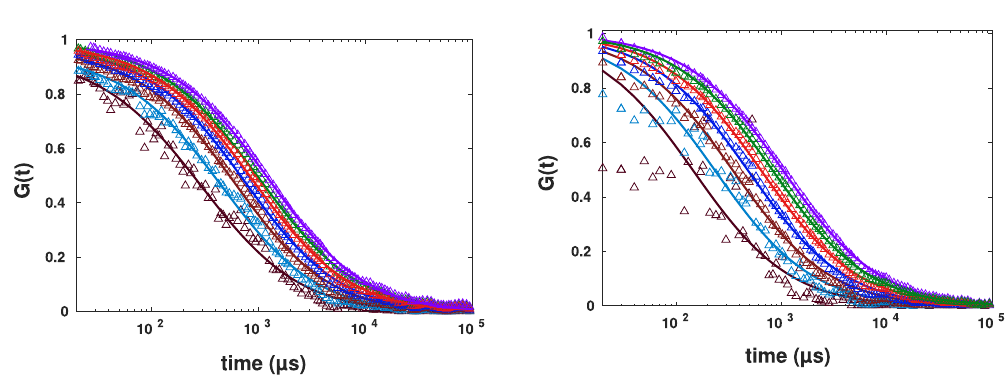
Figure 8. Experimental results for spot variation FCS (with r 0 − 0.4 r 0 from right to left) for diffusion of AlexaFluor647-labeled streptavidin in buffer crowded by 30% PEG1500 fitted to the standard formula. The intensity time traces were generated using kernel smoothing method for the left panel and binning for the right